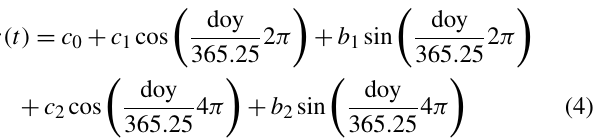
Figure 6. Global distributions of annual means of HZWD model coefficients z 1 (a) , z 2 (b) , and z 3 (c)